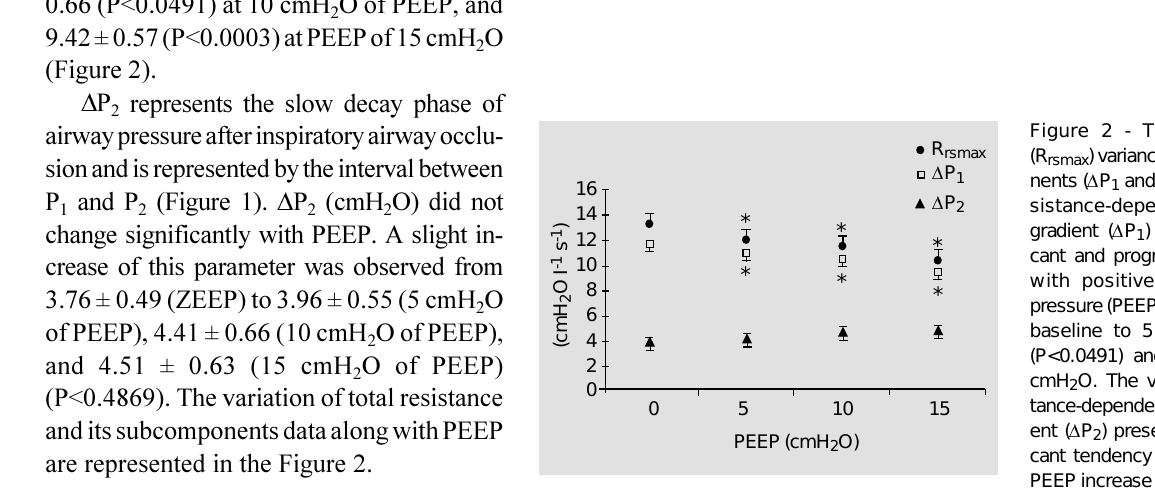
Table 2 - Hemodynamic